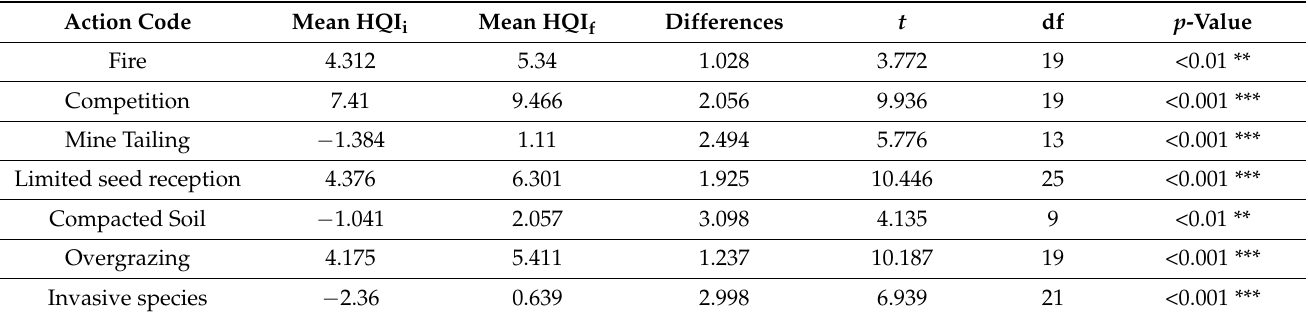
Table 7. Paired t -test to evaluate the effects of the habitat improvement actions implemented on the quality index (HQI i : initial value, HQI f : final value). p -value significance: * < 0.05, ** < 0.01, *** < 0.001.